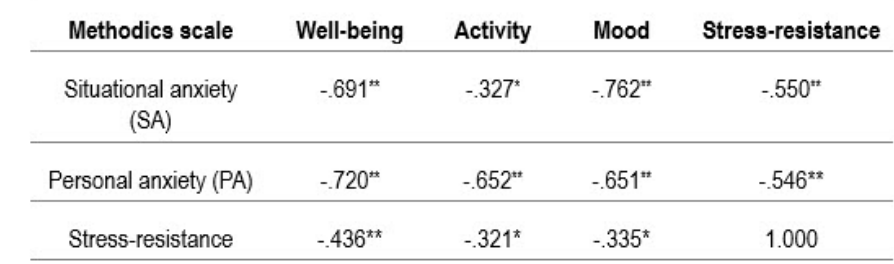
The results of the correlation analysis of anxiety and stress resistance specifics in Russian students